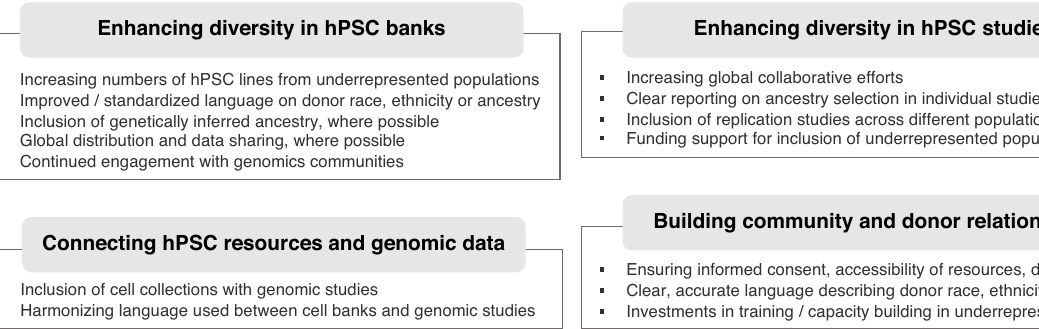
Fig. 2 | Considerations for reporting and expanding stem cell diversity. a Left, Examples of how individuals of European (blue) and Asian (green) ancestries are reportedincurrenthPSCbanks,includingCIRM(USA),WiCell(USA),Coriell(USA), SKiP(Japan)andHipSci(UK).Right,ExamplesofhowindividualsofEuropean(blue) and Asian (green) ancestries are reported in human genomic studies, including